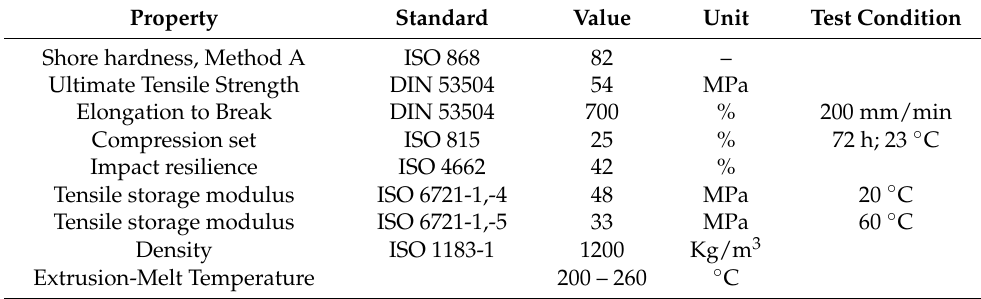
Table 1. Standardized properties for Recreus Filaflex.